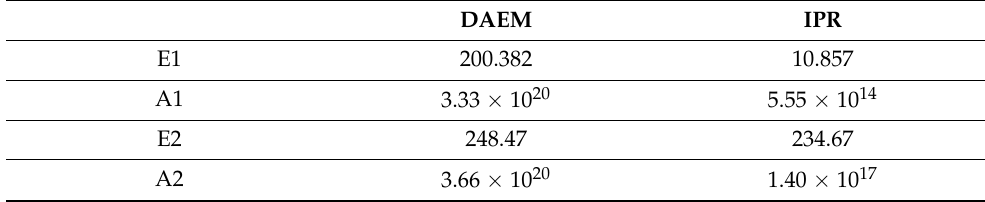
Figure 10. DTG experimental and calculated data at 5–30 ◦ C/min. Table 8. The calculated DAEM and IPR